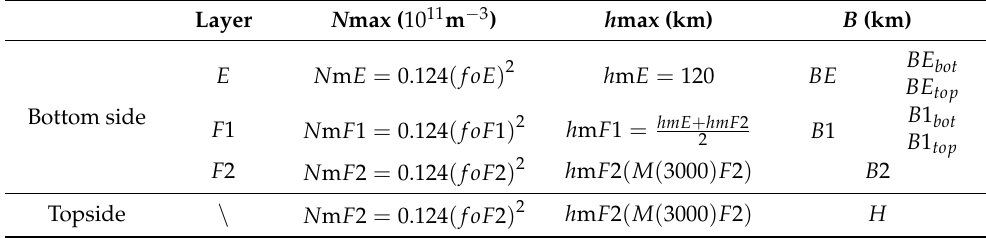
Table 1. Summary of NeQuick2 basic